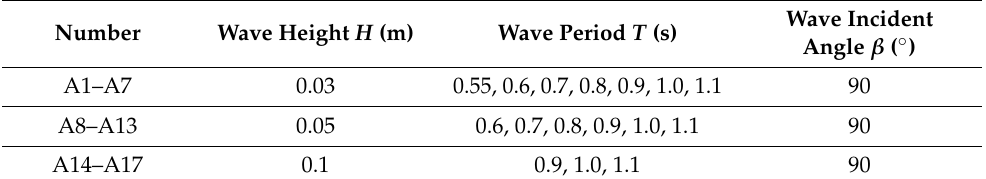
Table 5. Experimental wave conditions.